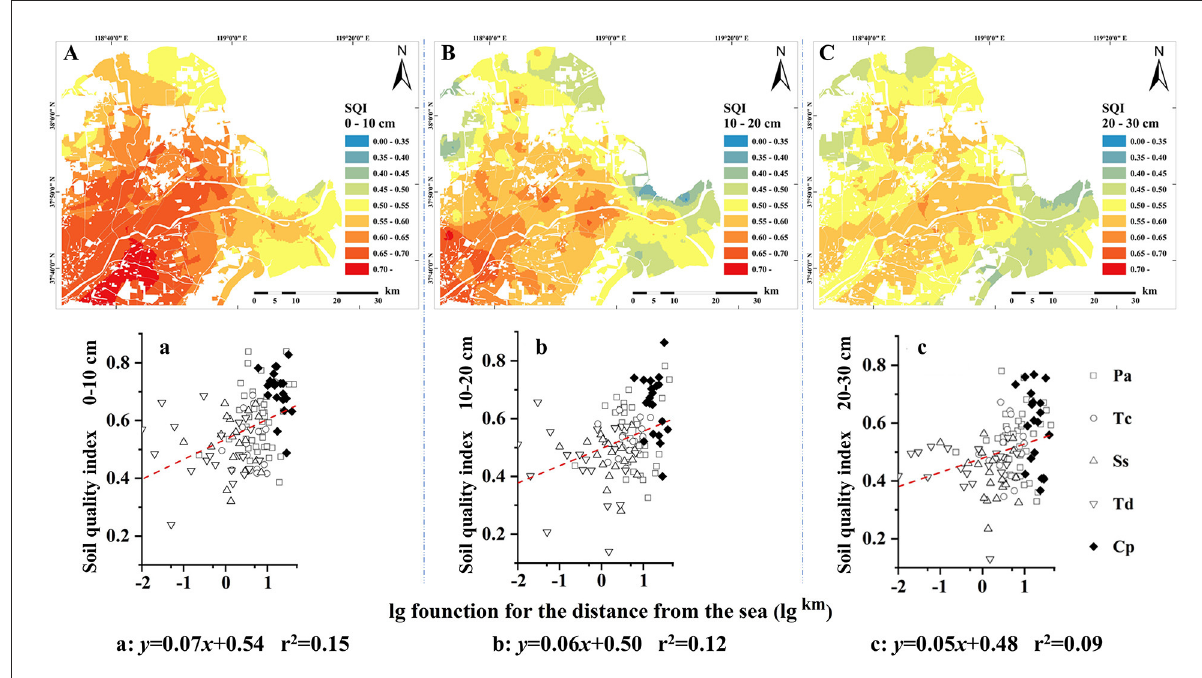
FIGURE3 The spatial distribution of SQI in soil profiles of 0–10cm (A) , 10–20cm (B) and 20–30cm (C) in the Yellow River